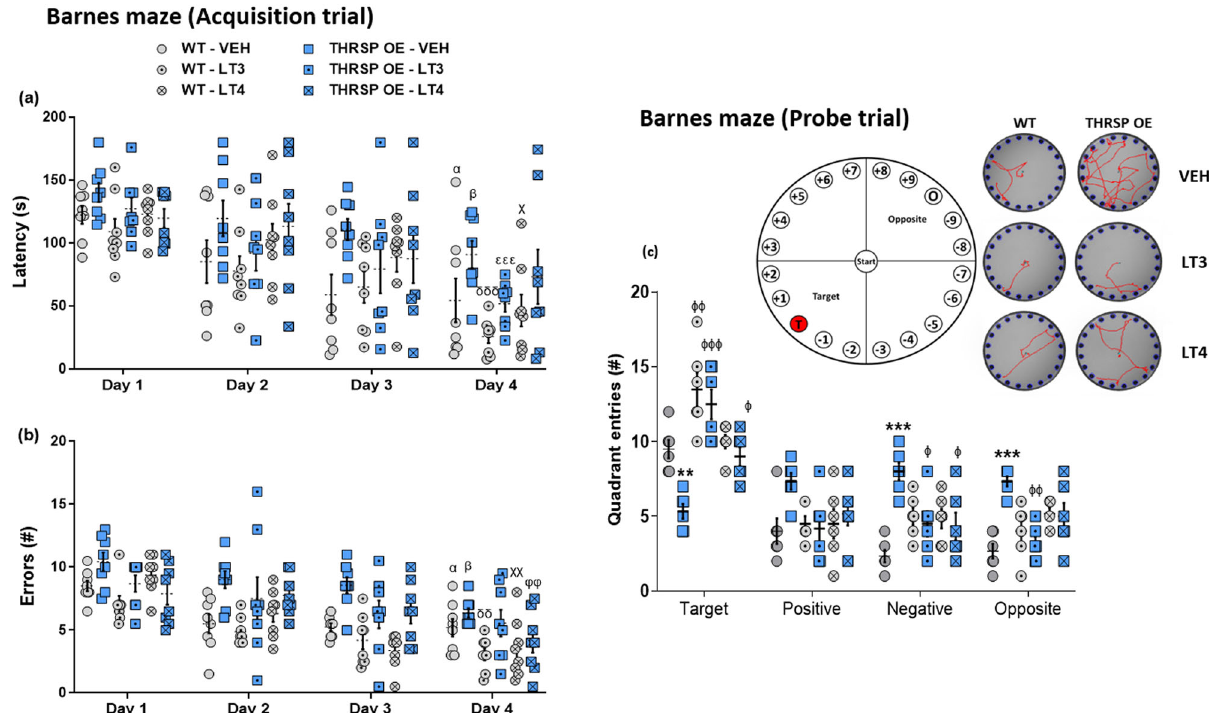
Fig. 7 Effects of TH replacement on memory impairment in THRSP OE mice. Another group of mice was treated with LT3 and LT4 (10 mg kg − 1 ). Mice started receiving TH two days prior to the start of acquisition trials (or during the habituation stage) and ended on the 5th day when a probe trial was conducted; thus, the total treatment period was seven days. During the acquisition and probe trial stages, the mice were introduced to the task 30 min after the last treatment dose, and the a latency and b errors in locating the target hole with the “ goal ” or escape box ( n = 8 mice/group) and the c frequency of visits towards each platform quadrant (i.e., target, positive, opposite, and negative) ( n = 6 mice/group) were scored; a repeated measures two-way ANOVA, F (5,42) = 3.50, P = 0.010; b repeated measures two-way ANOVA, F (5,42) = 9.68, P < 0.001; c two-way ANOVA, F (5,120) = 5.42, P < 0.001). TH replacement, particularly T3, improved memory impairment in THRSP OE mice. Values are presented as the mean ± S.E.M. α (WT-VEH), δ (WT-LT3), χ (WT-LT4), β (THRSP OE), ε (THRSP OE-LT3), φ (THRSP OE-LT4) P < 0.001, P < 0.01, by repeated measures two-way ANOVA with Bonferroni ’ s multiple comparisons relative to the effects of TH on the performance of individual strains (day 1 vs. 4 of acquisition trials). ** P < 0.01, *** P < 0.001 (relative to WT) and ϕ P < 0.05, ϕϕ P < 0.01, ϕϕϕ P < 0.05 (relative to VEH treatment) by two-way ANOVA with Bonferroni ’ s multiple comparison